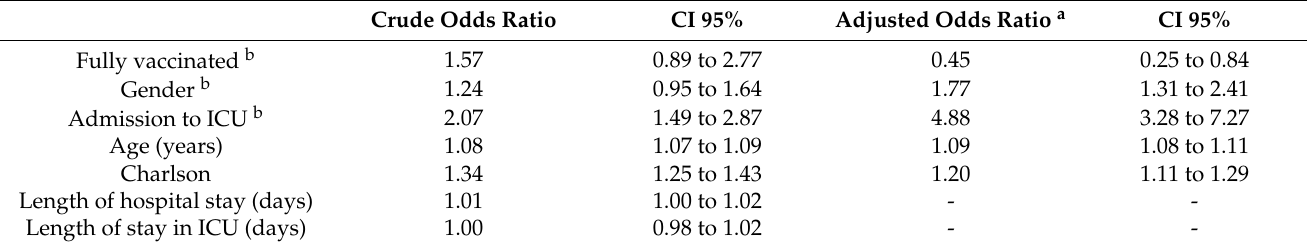
Table 2. Mortality